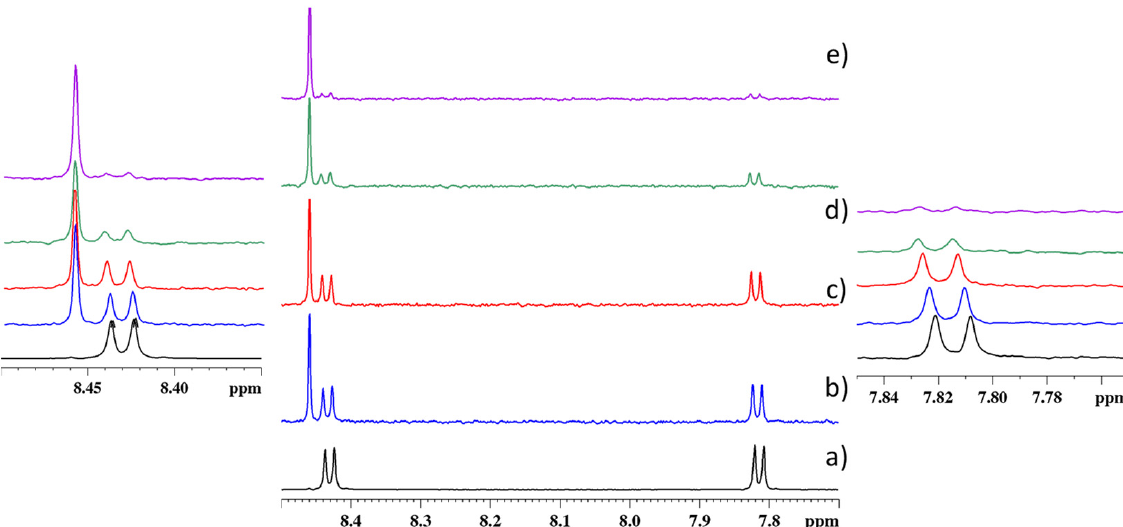
Figure 7. The 1 H NMR spectra of PTAS at different metal ion ratios in D 2 O at 600 MHz. ( a ) A 30 µ M PTAS solution; ( b ) 30 µ M PTAS and 15 µ M Pb 2+ solution (PTAS:Pb 2+ = 2:1); ( c ) 30 µ M PTAS and 30 µ M Pb 2+ solution (PTAS:Pb 2+ = 2:1); ( d ) 30 µ M PTAS and 60 µ M Pb 2+ solution (PTAS:Pb 2+ =